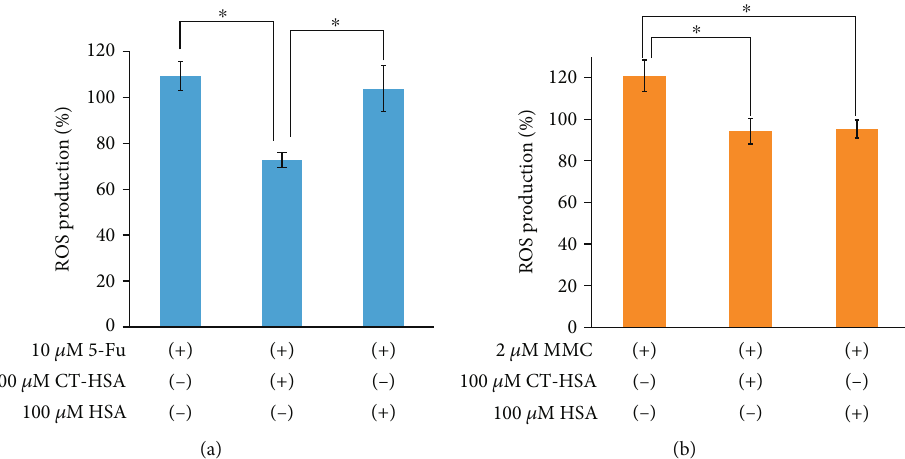
Figure 7: Intracellular ROS inhibition in HeLa cells treated with the CT – HSA conjugate (100 μ M) or HSA (100 μ M) together with (a) 5-Fu (10 μ M) or (b) MMC (2 μ M). The di ff erences between each sample were analyzed by t -test ( mean ± SD , n = 5 ); ∗ p < 0 : 05